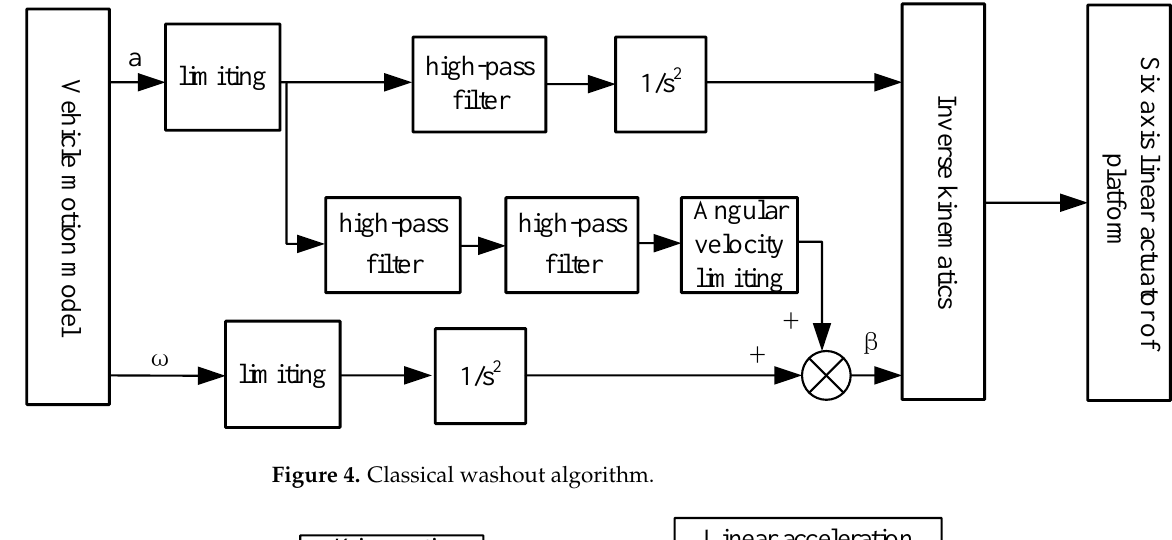
Figure 4. Classical washout algorithm.